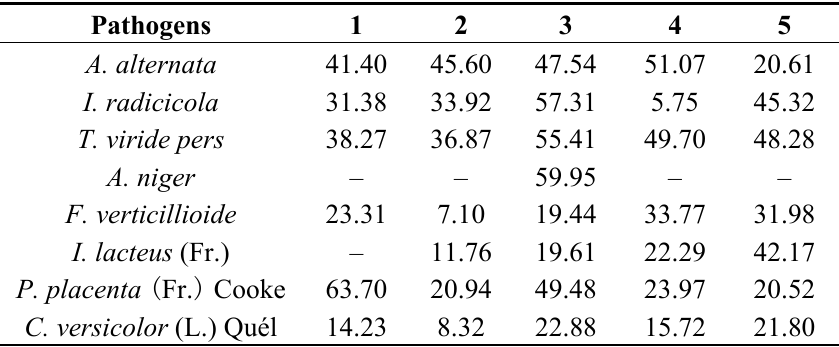
Table 2. Cell growth inhibitory rate (%) of several plant pathogenic fungi evaluated by compounds 1 – 5 at 200 μ